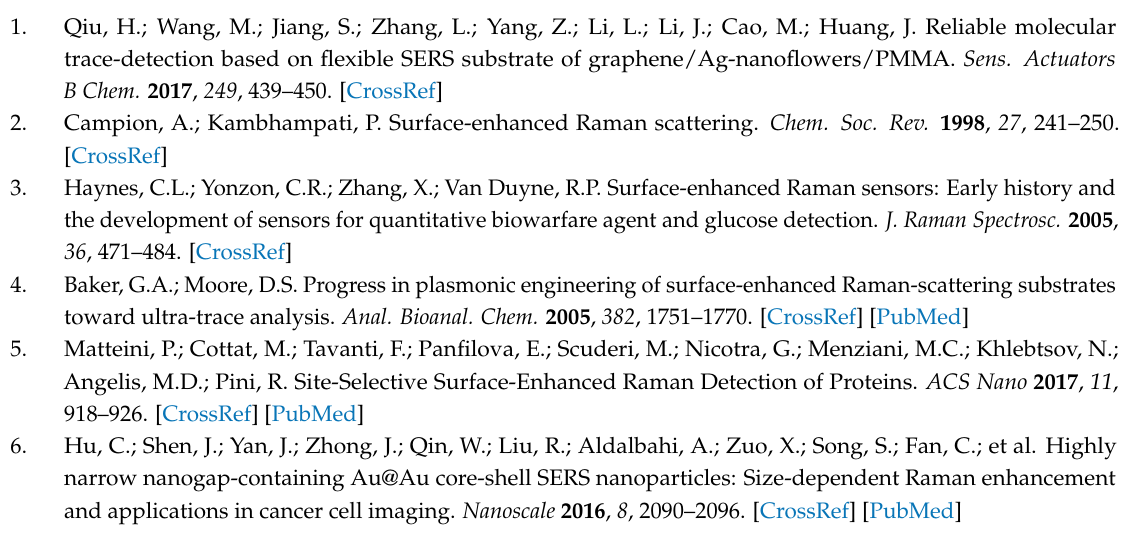
s1, Figure S1: SEM image used in the acquisition of the EDX spectrum shown in Figure 5d. The circle indicates the location of the GNP(s); Figure S2: Raman spectra of graphene-coatings: (a and b) GO (N=25) on a flat substrate and Ag dendrites, respectively; (c and d) rGO (N=5) on a flat substrate and Ag dendrites, respectively; (e, f) GNP (N=1) on a flat substrate and Ag dendrites, respectively. A Au-coated (CVD) polished Si wafer was used as flat substrate; Table S1: Standard deviations and relative standard deviations (%) for the data displayed in Figure